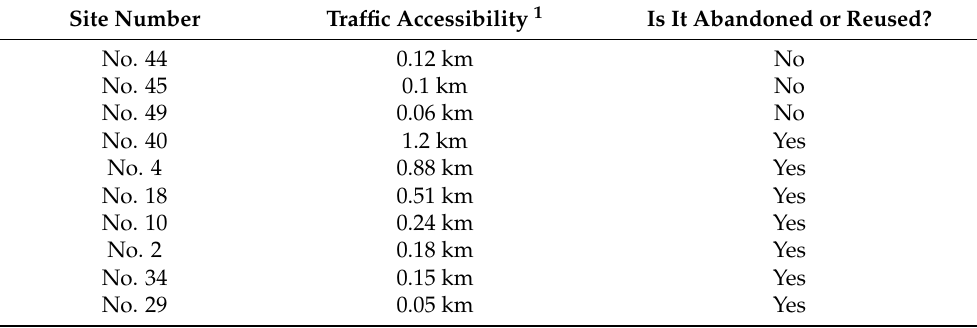
Table 3. Statistics of accessibility analysis of technology-intensive industrial heritage.